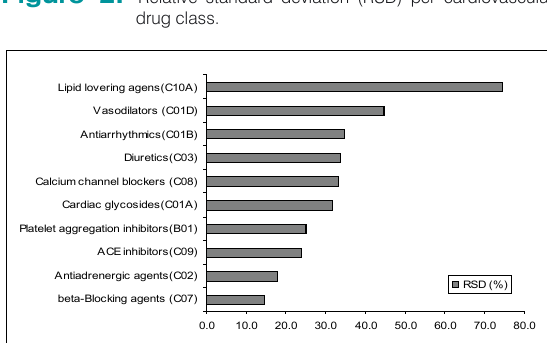
Figure 1. Comparison of certain groups of cardiovascular drugs consumption during 2003- 2007(DID).